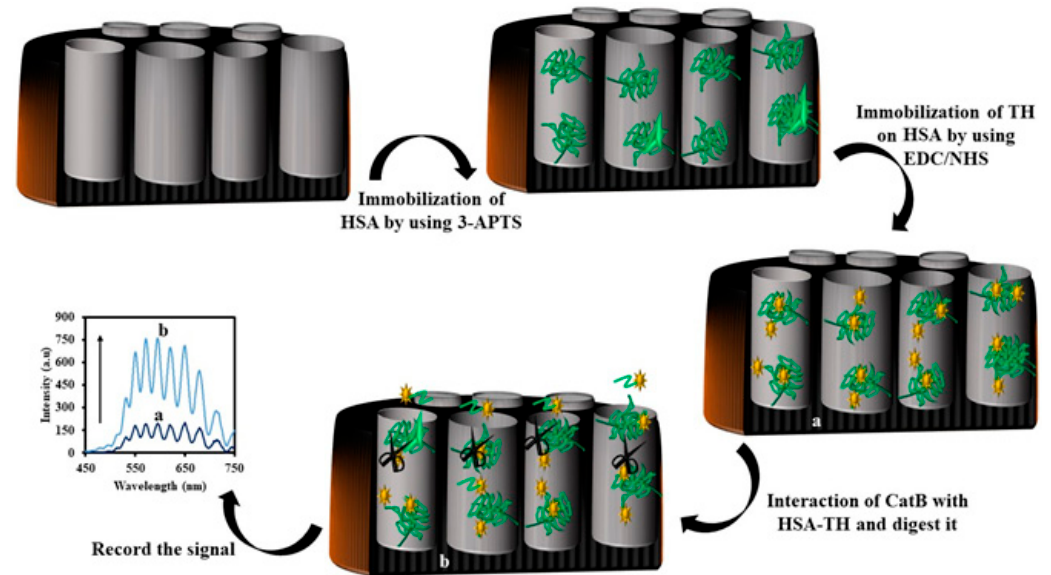
Figure 12. Schematic design of the nanoporous anodic alumina-human serum albumin-thionine (NAA-HSA-TH) for the determination of cathepsin B (Cat B) using interferometric reflectance spectroscopy